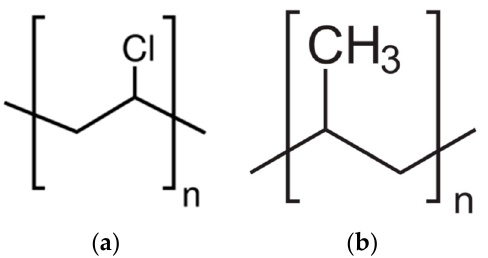
Figure 1. Structural model: ( a ) polyvinyl chloride [17]; ( b ) polypropylene [18].